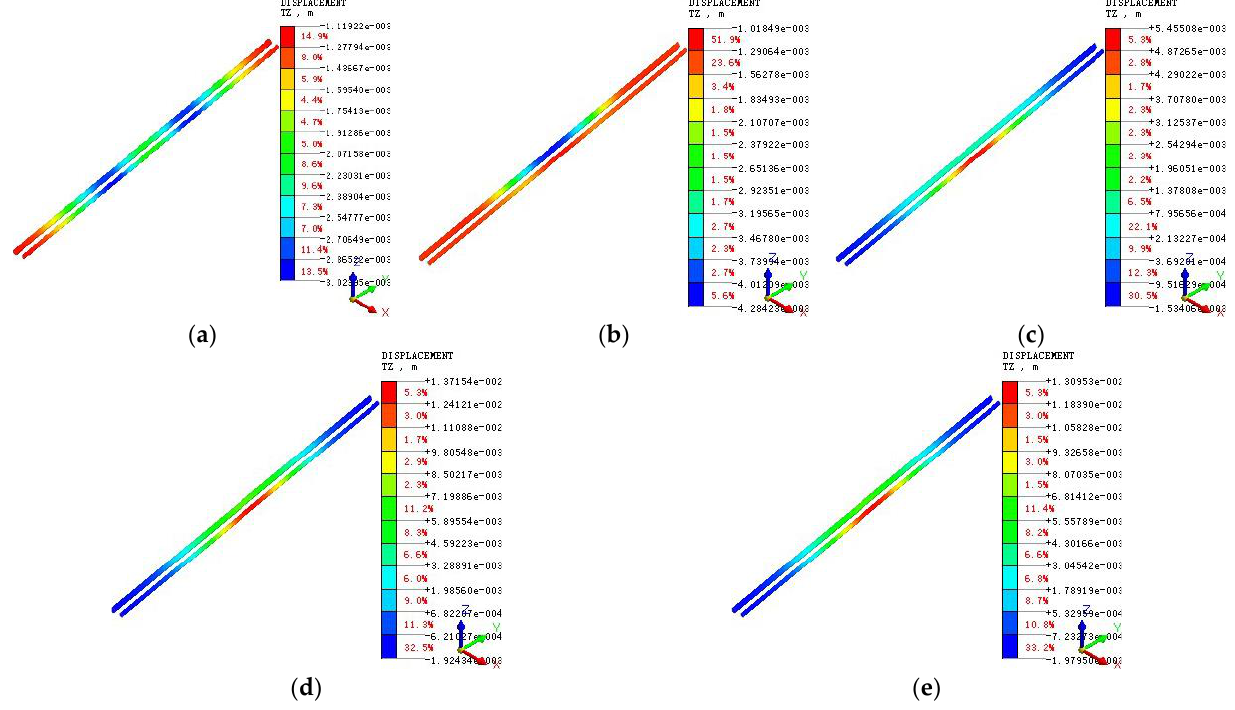
Figure 12. Contours of vertical displacements of pipelines at ( a ) Excavation Step 4; ( b ) Excavation Step 5; ( c ) Excavation Step 6; ( d ) Excavation Step 7; ( e ) Excavation Step 8.